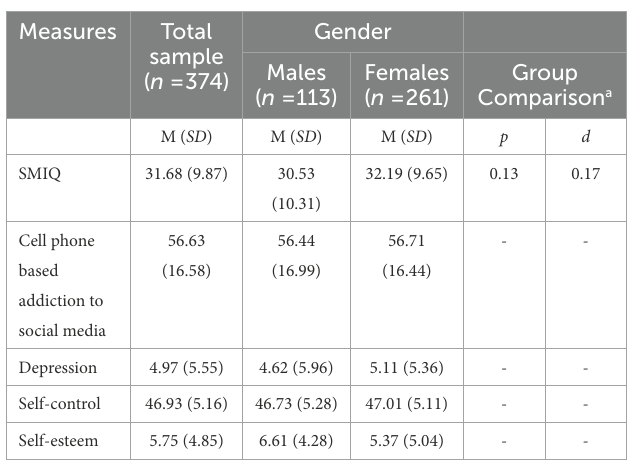
TABLE 2 Mean and standard deviation scores for the SMIQ.